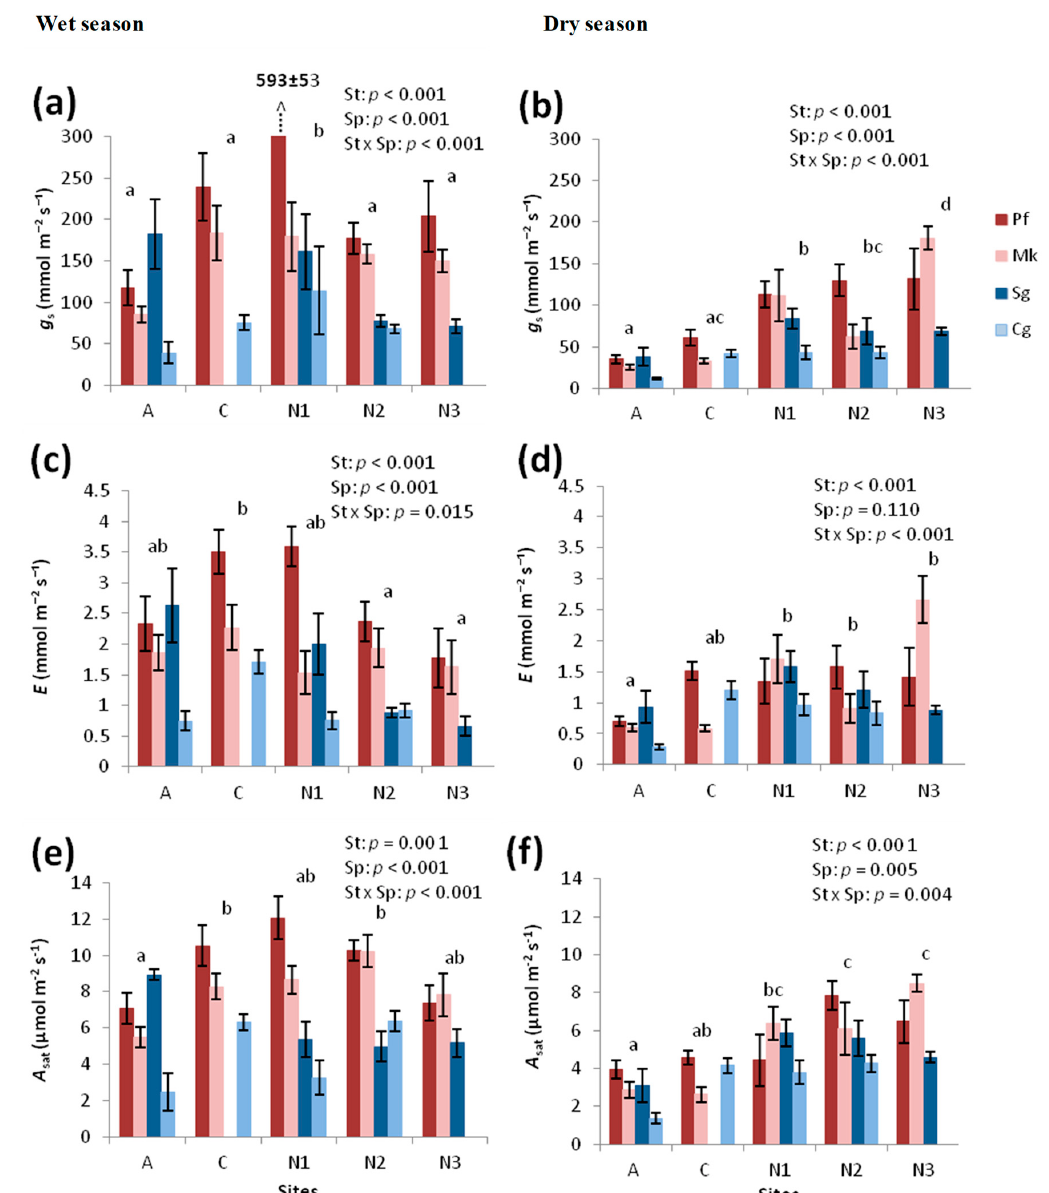
Figure 1. Leaf stomatal conductance ( g s ; ( a , b )), transpiration ( E ; ( c , d )), and light saturated net photosynthesis ( A sat ; ( e , f )) of four species (Sp) at five sites (St) along an elevation gradient, measured during wet ( a , c , e ) and dry ( b , d , f ) seasons. Error bars show variation (SE) among trees within each species at each site ( n = 6). P values for the effects of site (St), species (Sp), and their interaction (St × Sp) are shown in each graph. Significant overall differences among sites are indicated by different letters above the bars of each site. Explanations of site abbreviations are provided in Table 1; the order follows increasing elevation from left to right. Species abbreviations are based on first letters in genus and species: Pf = Polyscias fulva ; Mk = Macaranga kilimandscharica ; Sg = Syzygium guineense ; Cg = Carapa grandiflora .